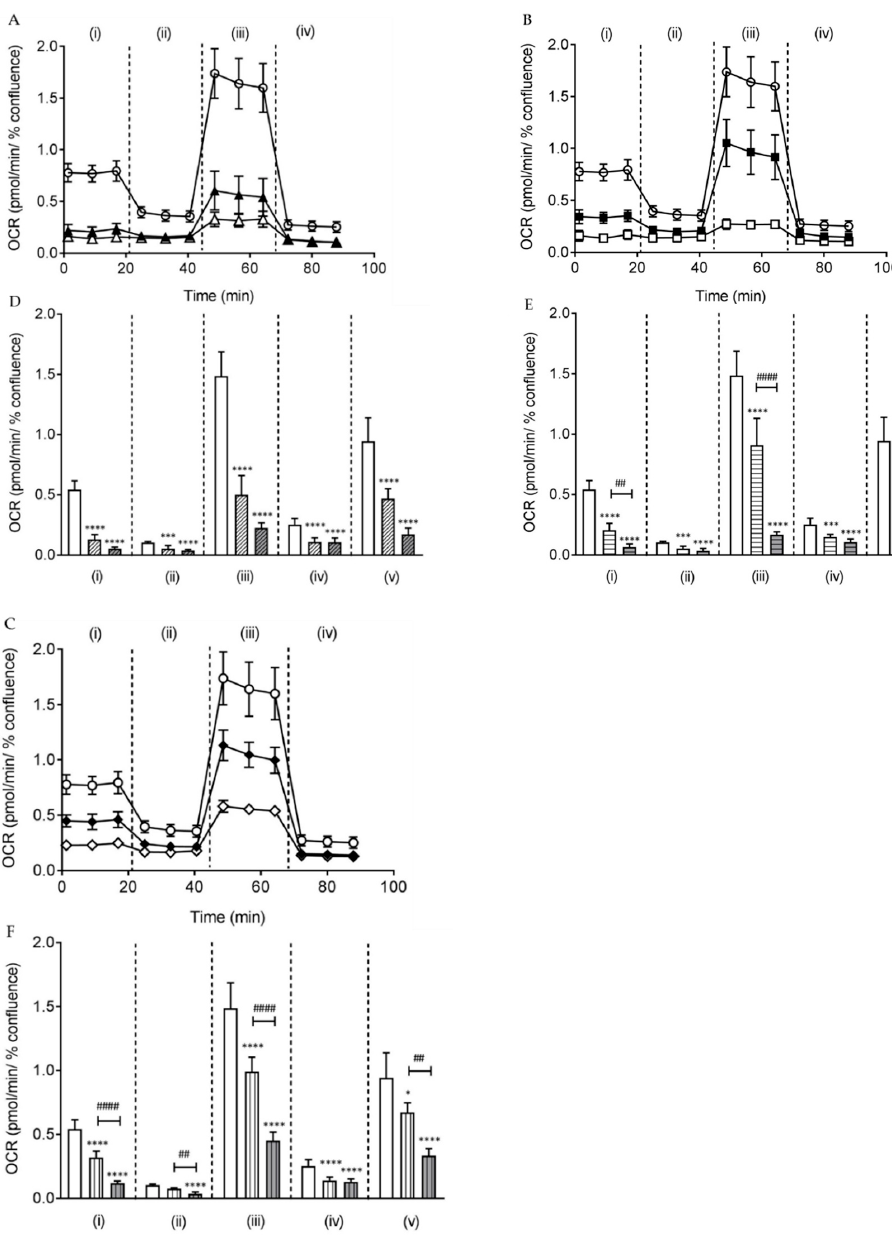
Figure 4. Oxygen consumption rate (OCR) measurement over time after 24 h of treatment of EC 15 and EC 40 for ( A ) butylone (filled and empty triangle, respectively), ( B ) pentylone (filled and empty square, respectively), and ( C ) MDPV (filled and empty diamond, respectively) with control (empty circle). Individual mitochondrial function parameters of EC 15 and EC 40 for ( D ) butylone (clear and grey diagonal bars, respectively), ( E ) pentylone (clear and grey horizontal bars, respectively), and ( F ) MDPV (clear and grey vertical bars, respectively): (i) basal respiration ( ## p < 0.01 vs. EC 15 pentylone, and #### p < 0.0001 vs. EC 15 MDPV), (ii) proton leak ( ## p < 0.01 vs. EC 15 MDPV), (iii) maximal respiration ( #### p < 0.0001 vs. EC 15 pentylone and EC 15 MDPV), (iv) non-mitochondrial respiration, and (v) spare respiratory capacity ( #### p < 0.0001 vs. EC 15 pentylone, and ## p < 0.01 vs. EC 15 MDPV). The spare respiratory capacity was calculated from the difference between maximal and basal respiration. Data are Mean ± SD obtained from at least four independent experiments normalized to the % confluence of cells. Different to the control; * p < 0.1, *** p < 0.001 and **** p < 0.0001.